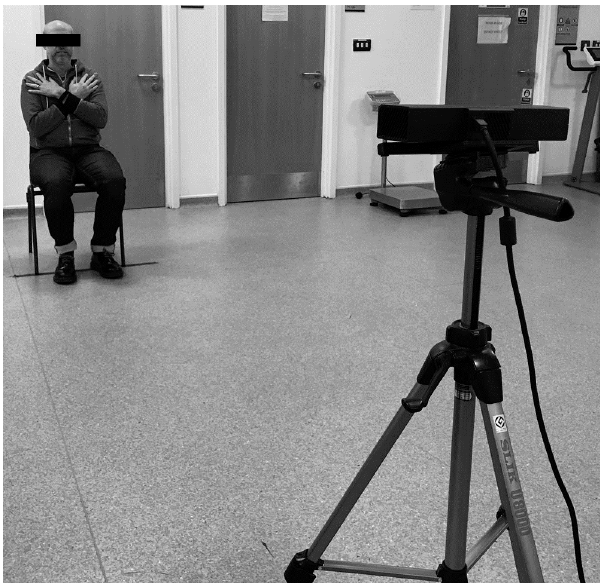
Figure 2. Example recording enviorment with the Microsoft Kinect One placed on a tripod at 70 cm.